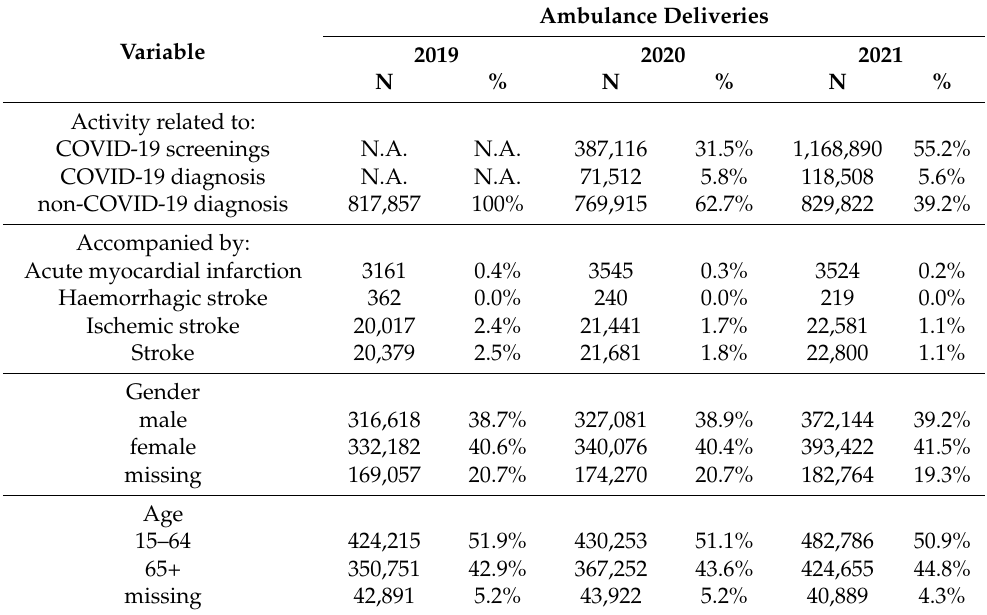
Table 1. Ambulance activity in Hungary,